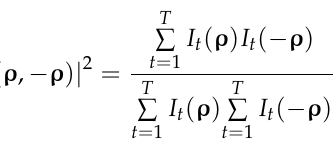
13 of 16 Figure 10. The experimental results for the averaged intensity at different propagation distances of the generated TLGSM beam with ( a – d ) the twist factor 𝜇 = 1.5 × 10 (cid:2879)(cid:2872) mm (cid:2879)(cid:2869) , ( e – h ) 𝜇 = 0 , and ( i – l ) 𝜇 = −1.5 × 10 (cid:2879)(cid:2872) mm (cid:2879)(cid:2869) . The TLGSM beam is obstructed by a sector-shaped opaque obstacle with